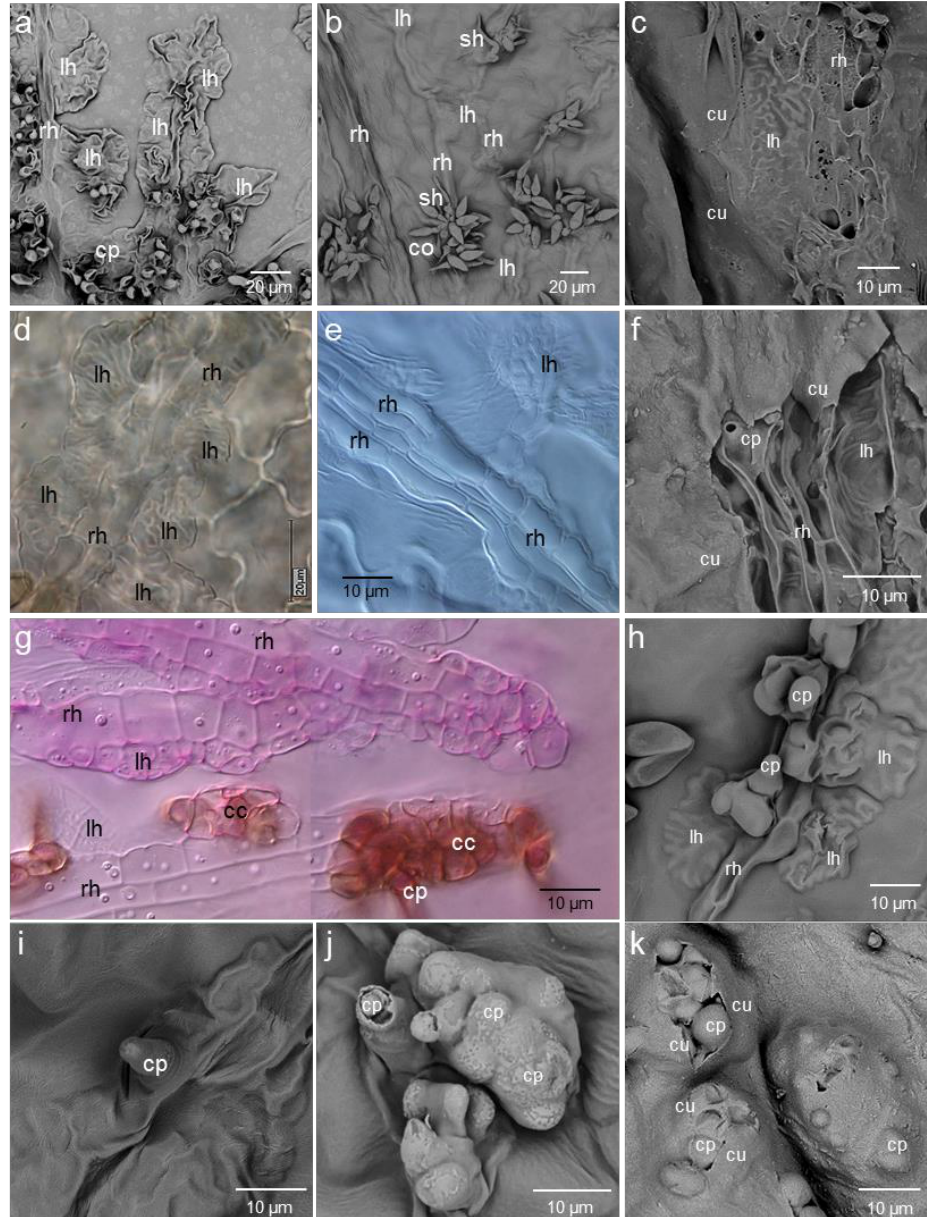
Figure 4. Sub-cuticular development of Venturia inaequalis isolates HS1 (wild-type, ( a , d , g , h , j )) and SW01 (melanin-deficient-mutant, ( b , c , e , f , g , i , k )). Overview on structures visible on the surface of apple leaves with runner hyphae (rh), lobated hyphae (lh), and the formation of conidiophores (cp) and conidia (co) breaking through the plant cuticle ( a , b ). Fungal structures on the epidermal cells of leaf tissue after cuticle removal ( c , f ); formation of runner hyphae and lateral lobated hyphae of V. inaequalis isolates HS1 ( d ) and SW01 ( e ); sub-cuticular hyphae of isolate SW01 (( g ), top ) and HS1 (( g ), bottom ) in the same leaf tissue with melanised conidiogenic cells (cc) for HS1 only; formation of conidiophores of HS1 ( h ) and SW01 ( i ) still covered by the leaf cuticle; penetration of the cuticle by the pathogen’s structure, formation of holes in the cuticle ( j , k ). Images of samples taken 8 to 10 dpi from scanning electron microscopy ( a – c , f , h – k ) and brightfield microscopy ( d , e , g ), without and with staining (staining with acid fuchsin in ( g